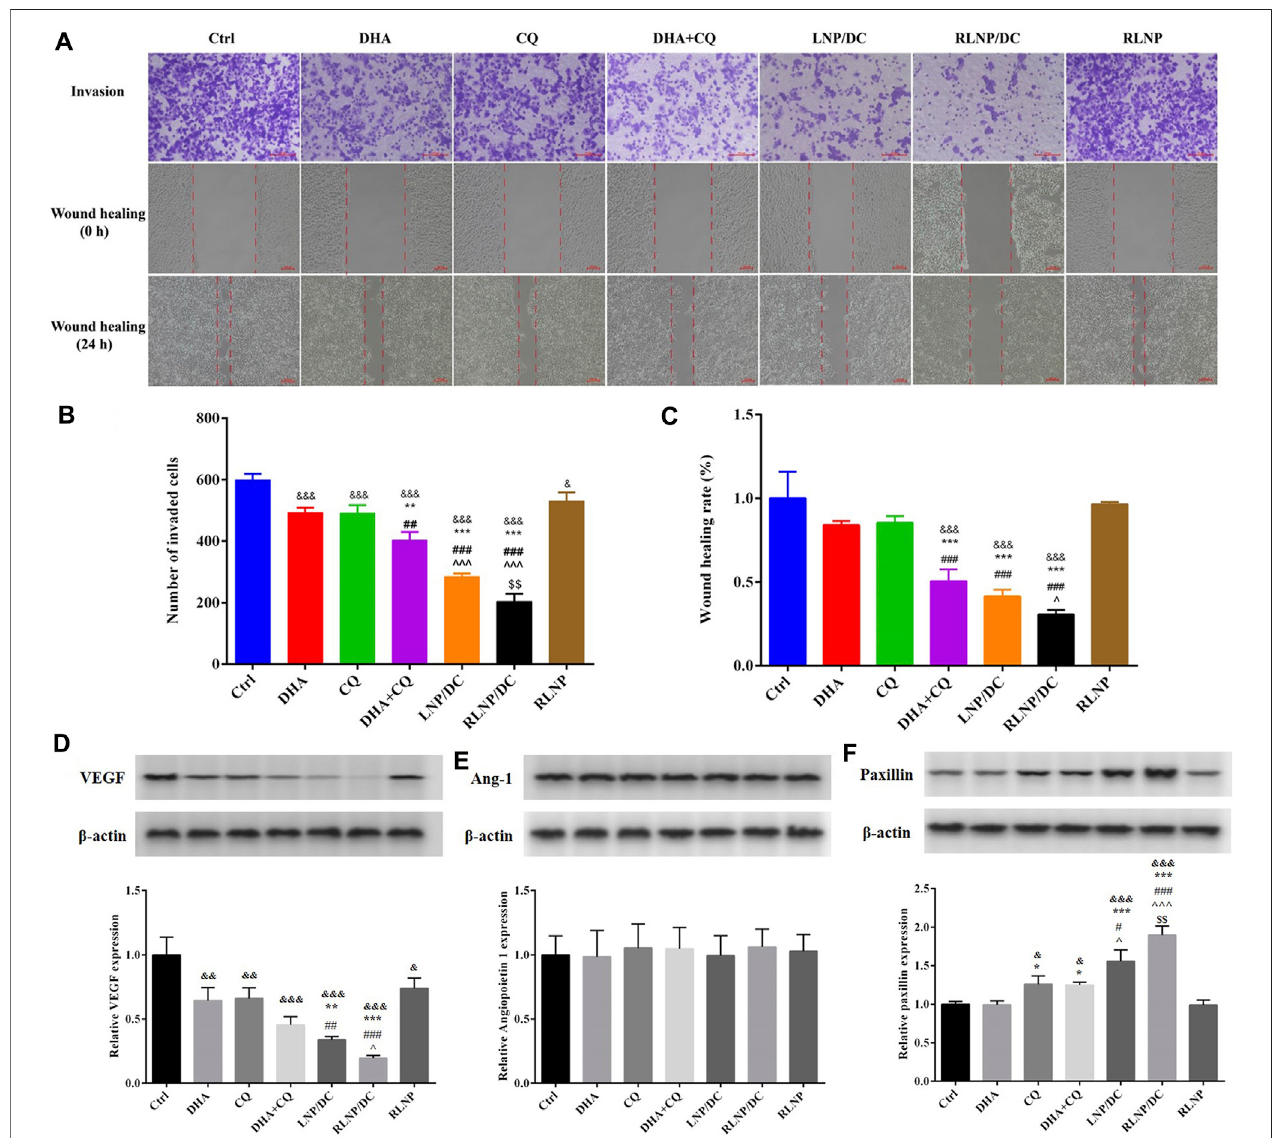
FIGURE 6 | Assessment of in vitro anti-metastasis effect and detection of metastasis-related proteins. (A – C) Transwell invasion assay and wound healing rate assay in HCT116 cells after treatment by DHA, CQ, DHA + CQ, LNP/DC, RLNP/DC, and RLNP. (D – F) Expression level of metastasis-related proteins including VEGF, Ang-1, and Paxillin after 24 h of treatment. Each bar represents the mean ± SD ( n (cid:1) 3). & p < 0.05, && p < 0.01, and &&& p < 0.001 vs. Ctrl; * p < 0.05, ** p < 0.01, and *** p < 0.001 vs. DHA; ## p < 0.01 and ### p < 0.001 vs. CQ; ^ p < 0.05 and ^^^^ p < 0.001 vs. DHA + CQ; $$ p < 0.01 vs. LNP/DC.